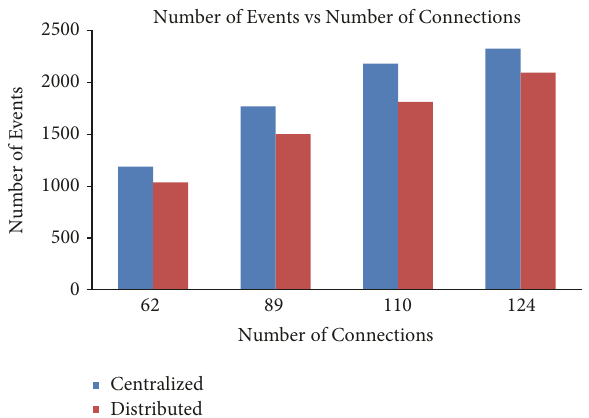
Figure 17: Number of events vs number of connections in Germany topology.